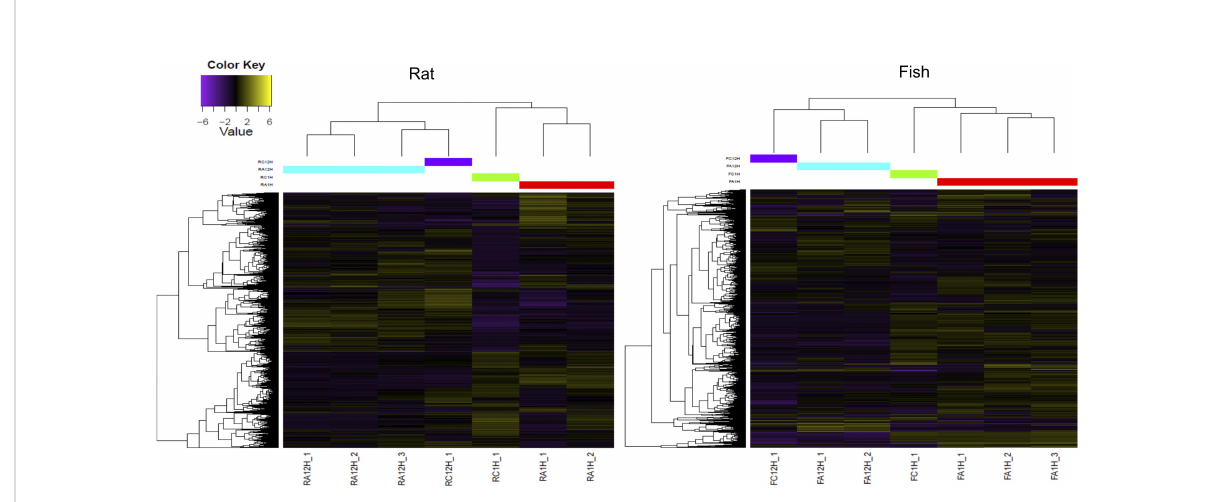
FIGURE 2 Heatmap showing highly signi fi cant differentially expressed genes (FDR <0.001 and logFC >2) in the rat ( R. norvegicus ) and fi sh ( D. labrax ) peripheral blood leukocytes (PBLs) after 1 vs. 12 h of treatment with A. pegref fi i crude extract. Note that the unstimulated controls were excluded from differential expression analyses due to no replicate availability, but a single pooled sample is shown in the diagram for visual comparison. The colour scale represents the Log2 fold change (Log2FC). Different colours on the central upper bar indicate the different clusters to which each sample was related. Sample codes for the rat: RC1H_1 — control 1 h, RC12H_1 — control 12 h; RA1H_1, RA1H_2 — biological replicas 1 h post-stimulation; RA12H_1, RA12H_2, RA12H_3 — biological replicas 12 h post-stimulation; and for the fi sh: FC1H_1 — control 1 h, FC12H_1 — control 12 h;